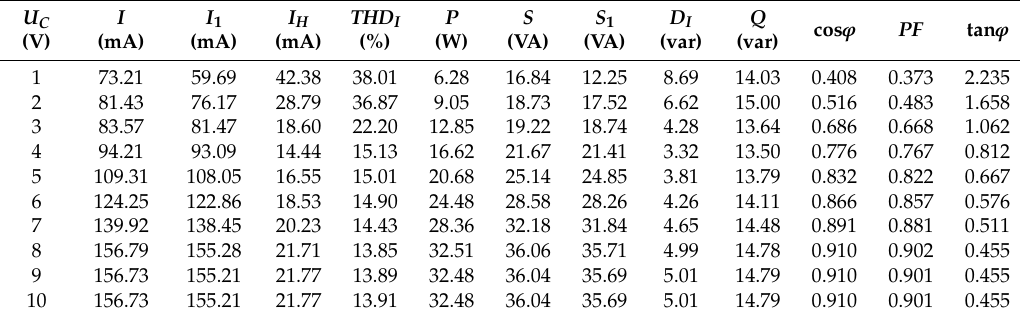
Table 11. Summary of measured values of electrical parameters of the LED4 luminaire.